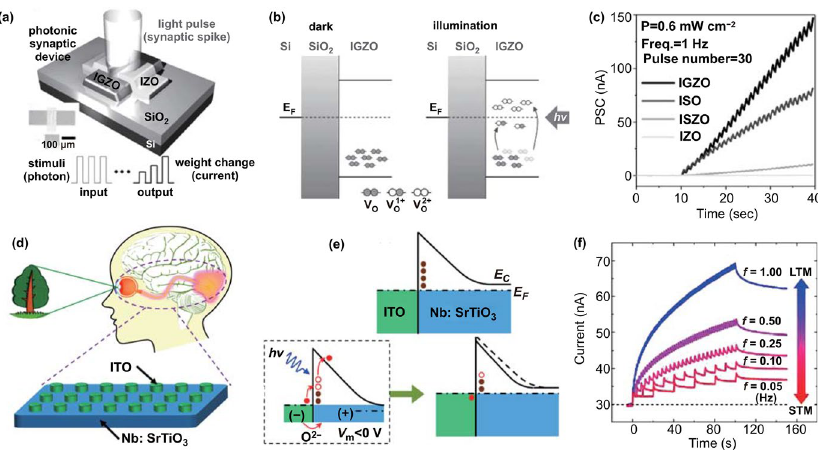
Fig. 5 a Schematic of IGZO-based transistor synaptic device. b Schematic of the corresponding mechanism of the response stimulated by light pulse. c Postsynaptic current (PSC) trends of the IGZO, indium–strontium oxide (ISO), indium–strontium–zinc oxide (ISZO), and indium–zinc oxide (IZO)-based devices as the pulse numbers increased. a – c Reproduced with permission from Ref. [92]. d ITO/Nb:SrTiO 3 Schottky hetero- junction artificial optoelectronic synaptic devices. e Schottky barrier profile before and after light illumination accompanied by positive voltage stress. f A behavior of STM-to-LTM transition versus the increase of spike frequency. d – f Reproduced with permission from Ref.